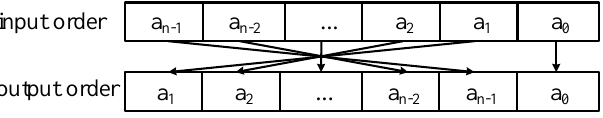
Figure 2. Proposed reverse